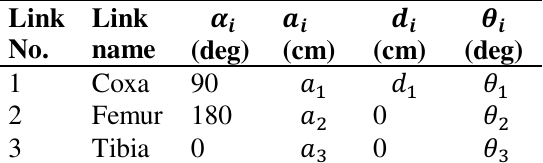
Table 1, The Denavit-Hartenberg parameters table for one leg in our quadruped robot